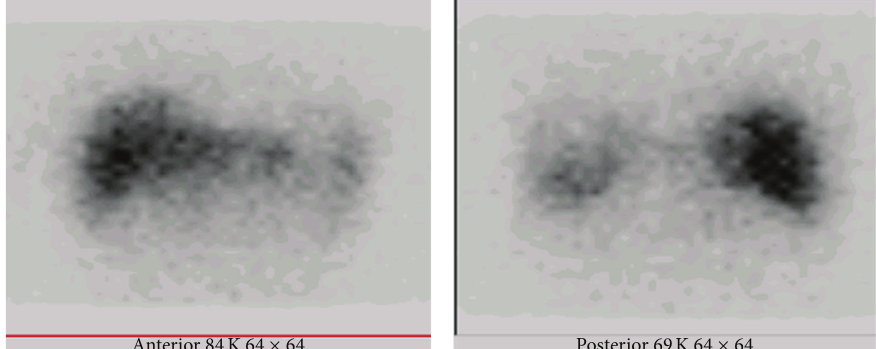
Figure 5: Unusual findings of splenic activity visualized after RE with 32 P